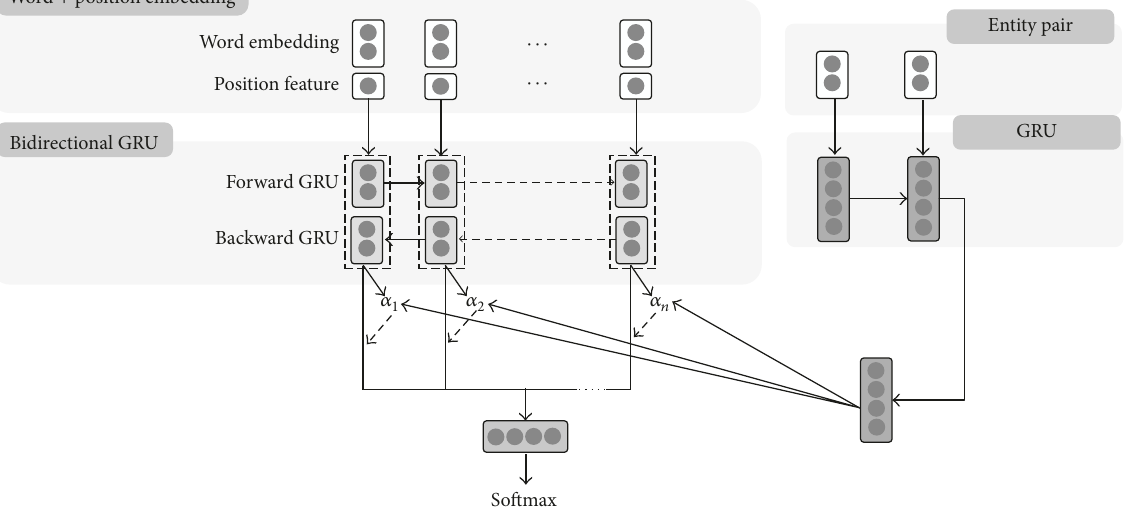
Figure 2: The overview of entity pair-based attention mechanism. With the generated entity pair embedding, the information distribution of word-level representations is measured by the dot product of entity pair embeddings and Bi-GRU word-level